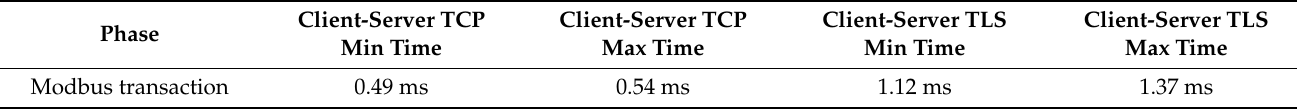
Table 5. Latencies measurements of the fourth phase of mbapSSI.